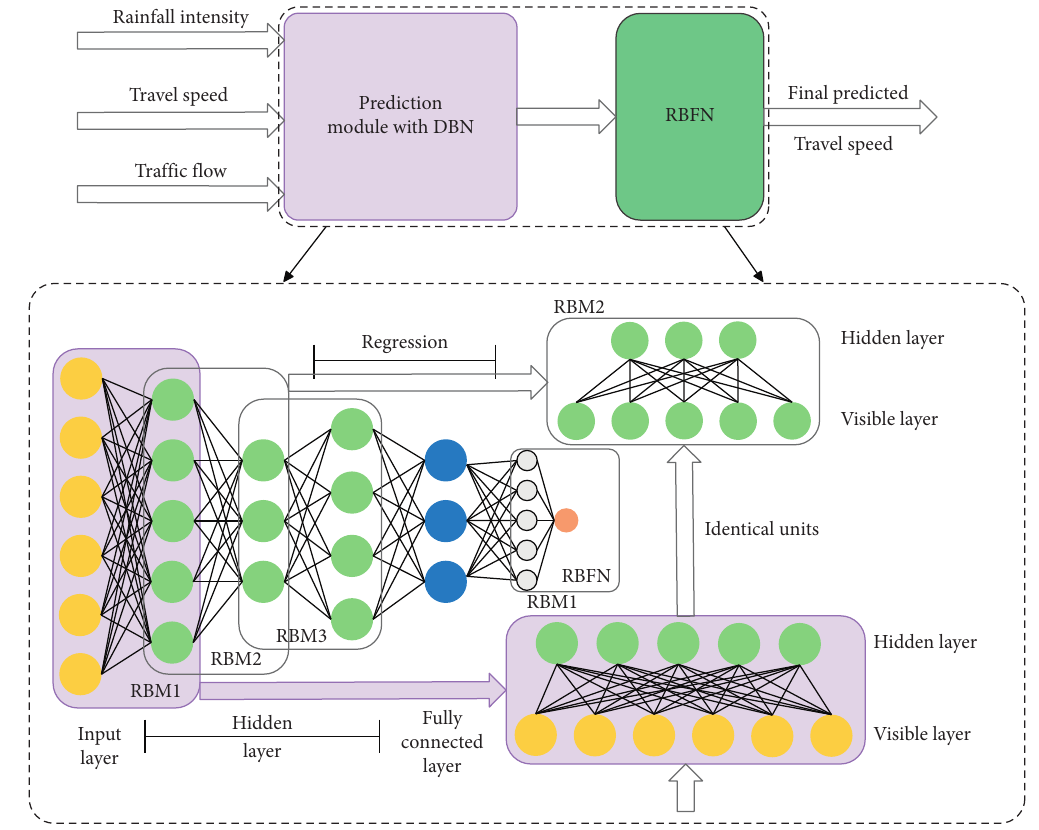
Figure 1: The structure of travel speed prediction with decision fusion.